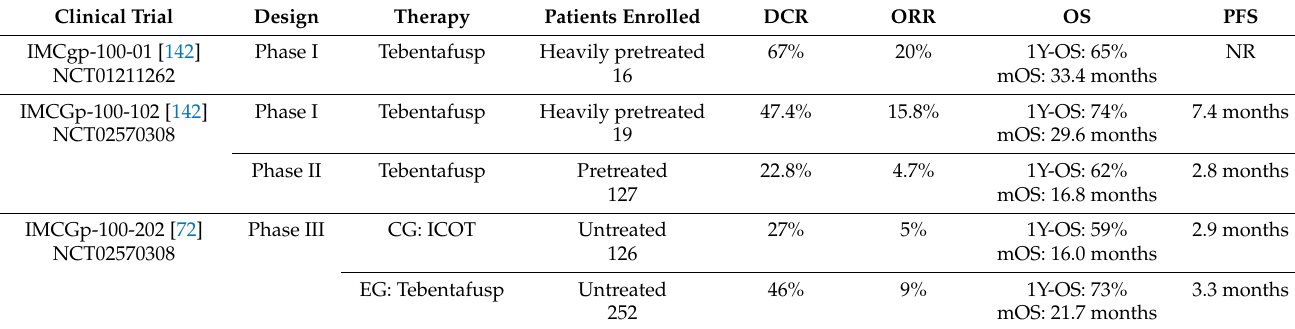
Table 5. Clinical trials with tebentafusp in metastatic UM